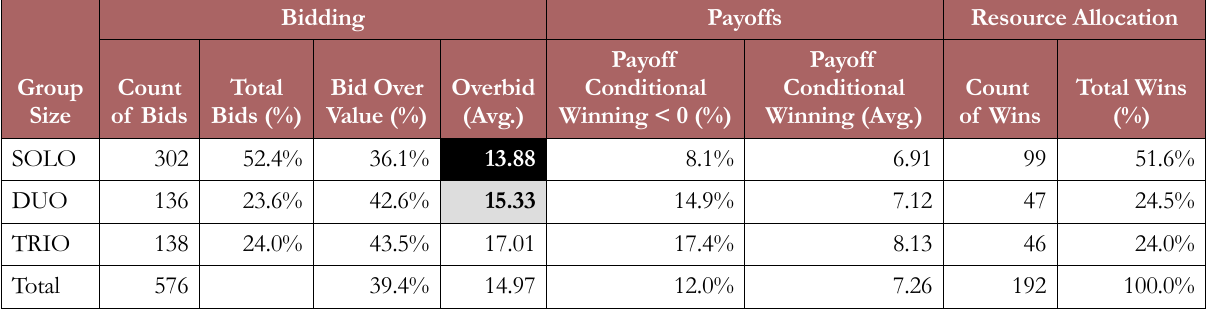
Table 3. Experimental game: comparisons by group size